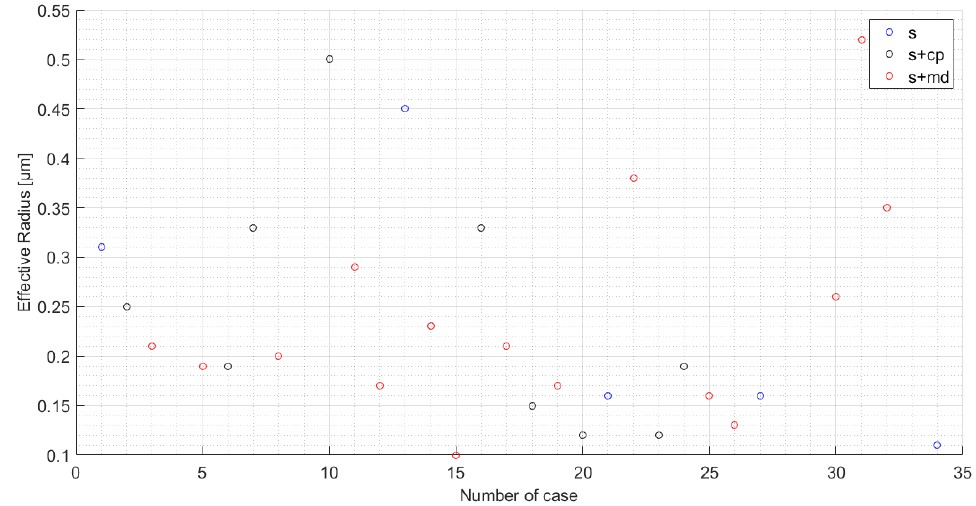
Figure A1. Effective radius ( µ m) for the s (blue), s+cp (black), and s+md (red) aerosol layers, numbered as shown in Table A1 in Appendix A.